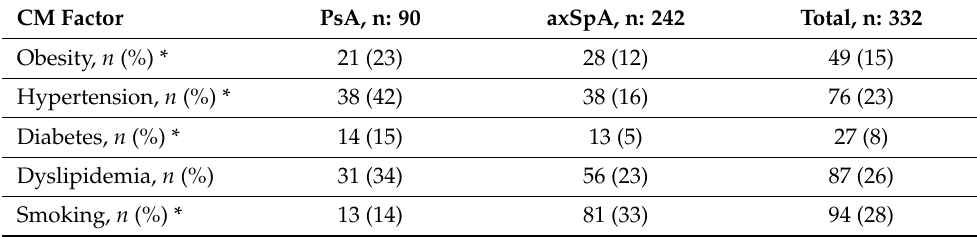
Table 2. Distribution of cardiometabolic risk factors among the study populations.